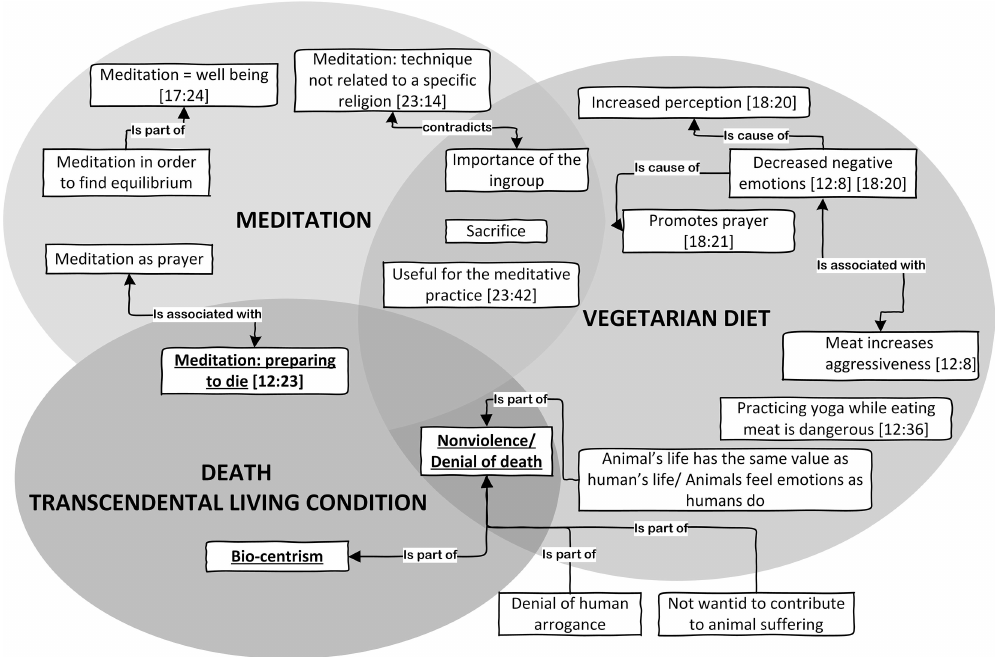
Figure 3. Against death. Note. In each box of the graph, the first number in brackets indicates the quotation size (total number of quotations of the code), while the second number indicates the quotation cited in the text as